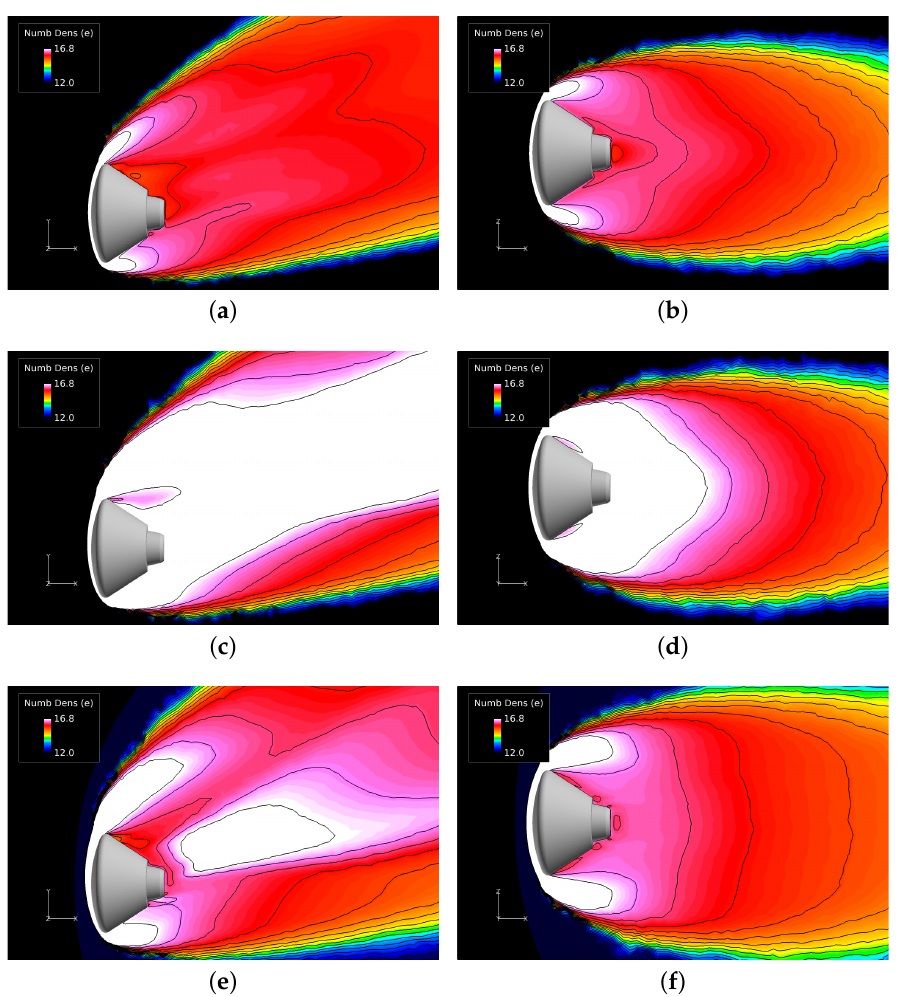
Figure 11. Number density of electrons around the ESA ARD at each altitude. ( a ) Results at an altitude of 85 km ( x – y plane); ( b ) results at an altitude of 85 km ( x – z plane); ( c ) results at an altitude of 70 km ( x – y plane); ( d ) results at an altitude of 70 km ( x – z plane); ( e ) results at an altitude of 60 km ( x – y plane); ( f ) Results at an altitude of 60 km ( x – z